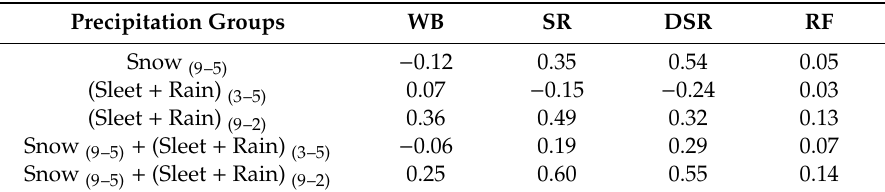
Table 6. Correlations between cold season runo ff and cold season precipitation. Precipitation